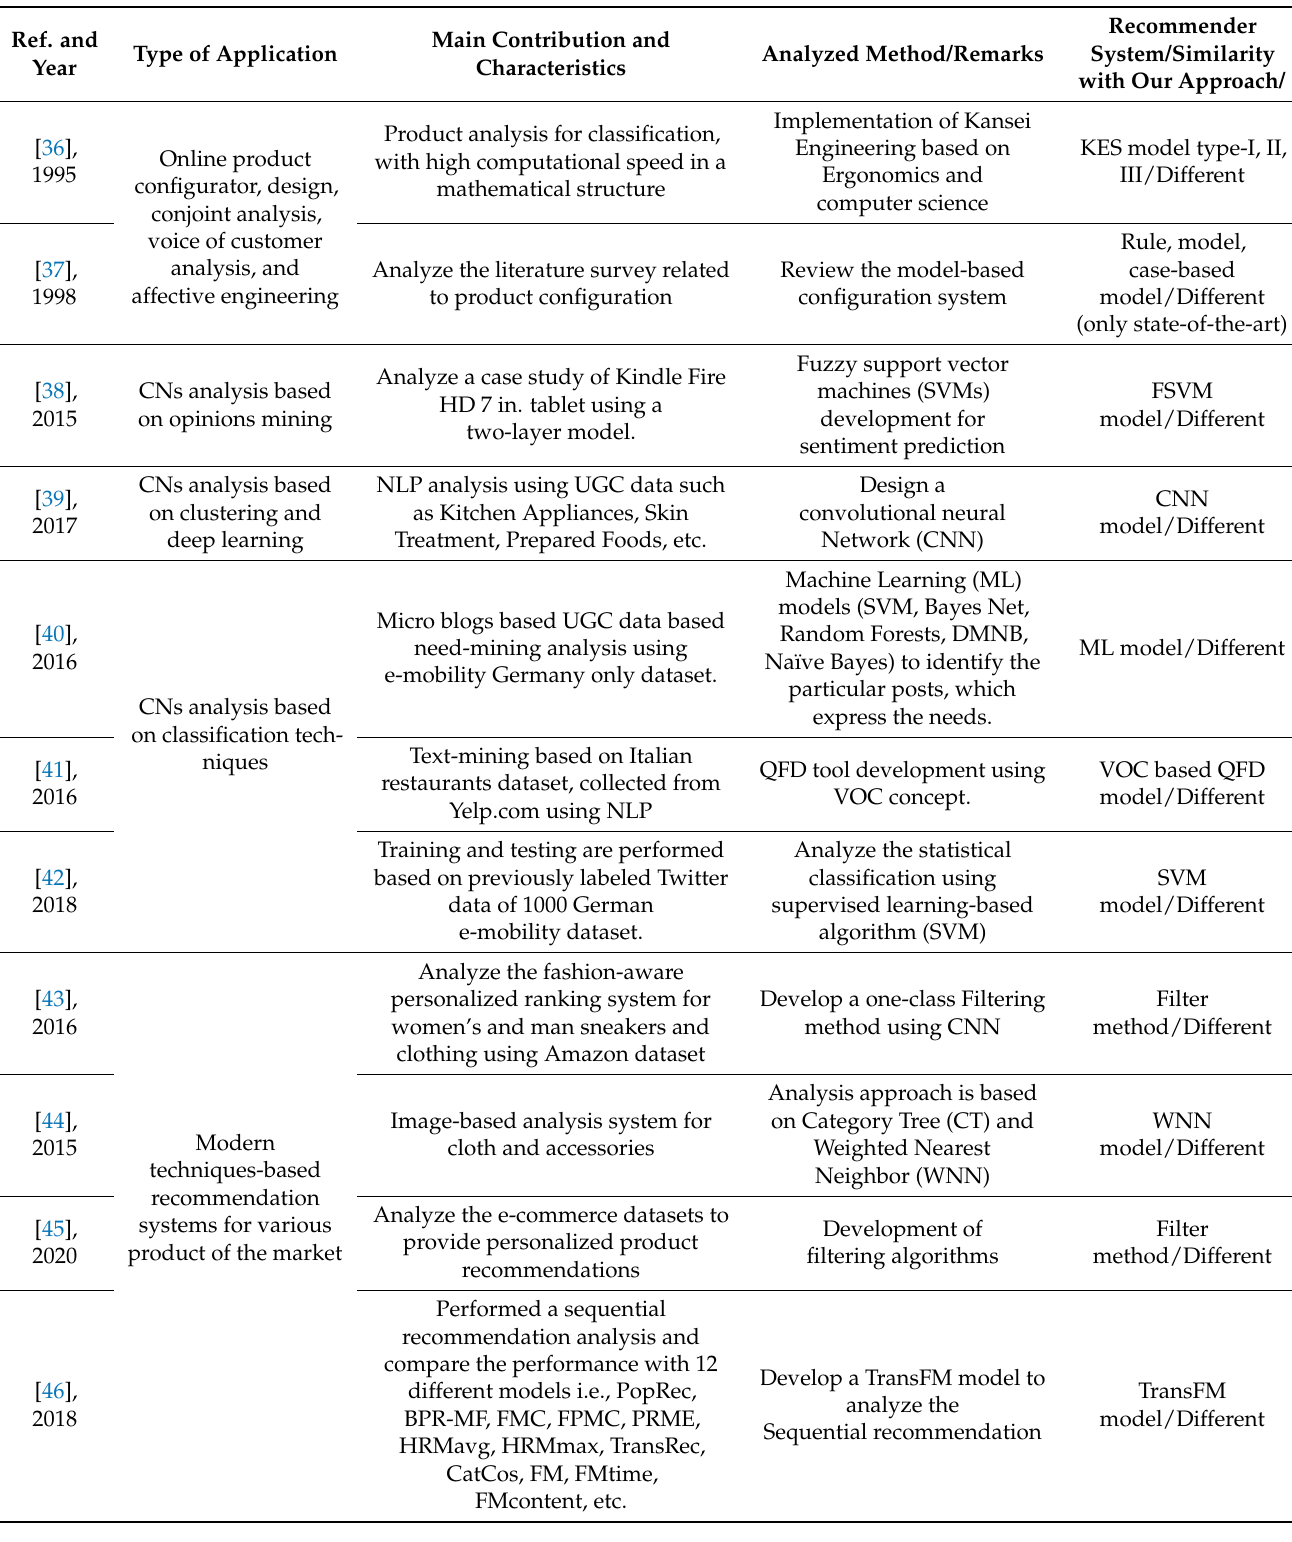
Table 4. Summary of the online product configuration, identification, recommendation system using advanced tech-